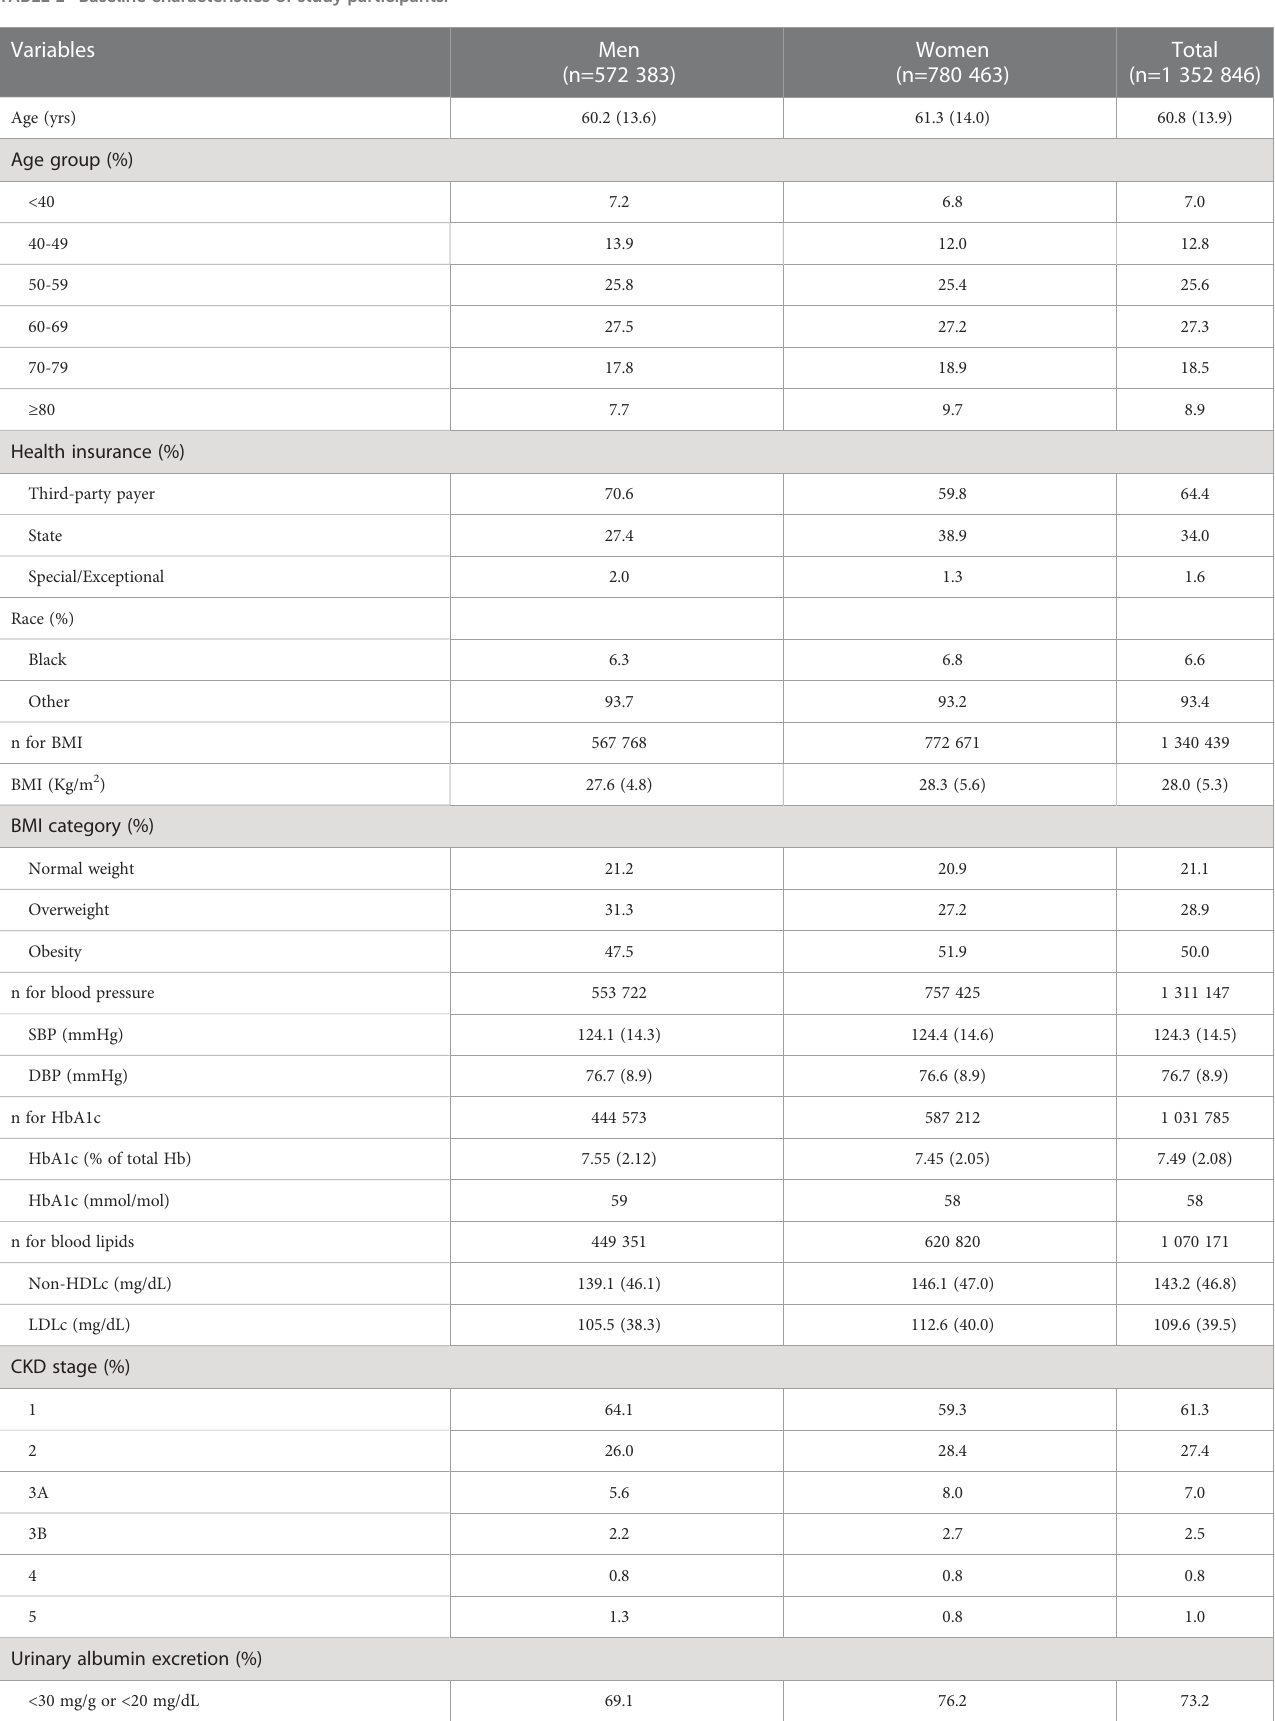
TABLE 1 Baseline characteristics of study